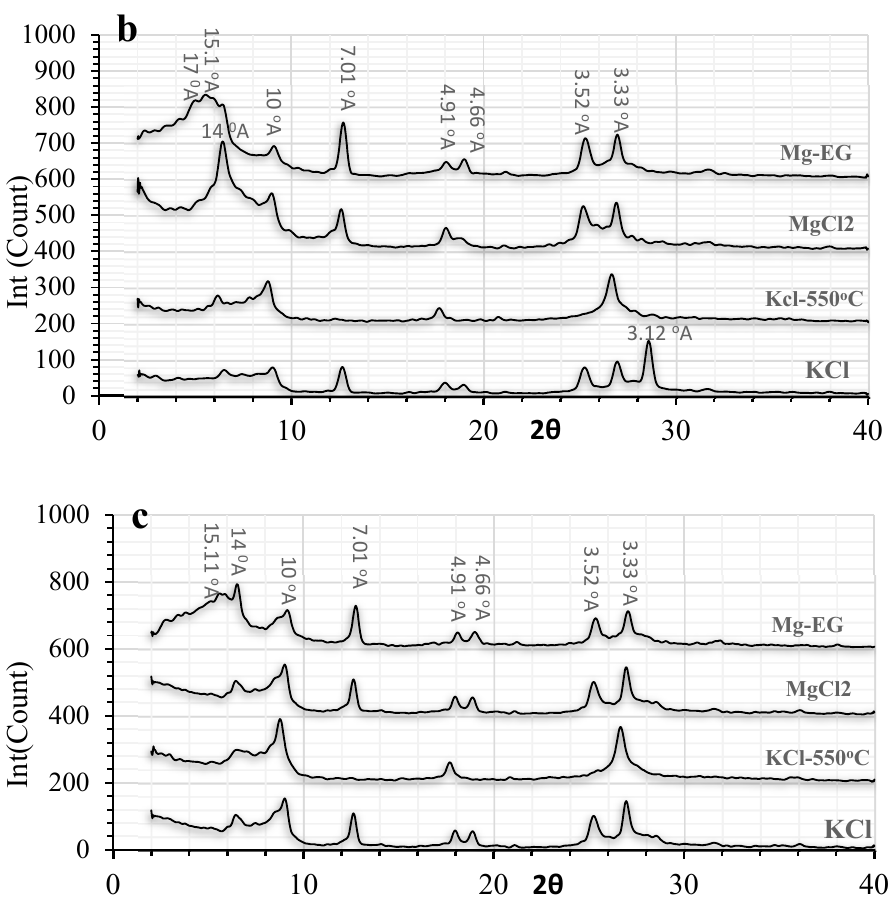
Figure 3. X-ray diffractograms of the clay fraction in three selected soils with various CEC content, ( a ) soil sample with CEC = 38.7 cmole c kg − 1 , CA:2.85; ( b ) soil sample with CEC = 26.7 cmole c kg − 1 CA:1.51; ( c ) soil sample with CEC = 18.3 cmole c kg − 1 , CA:1.02.